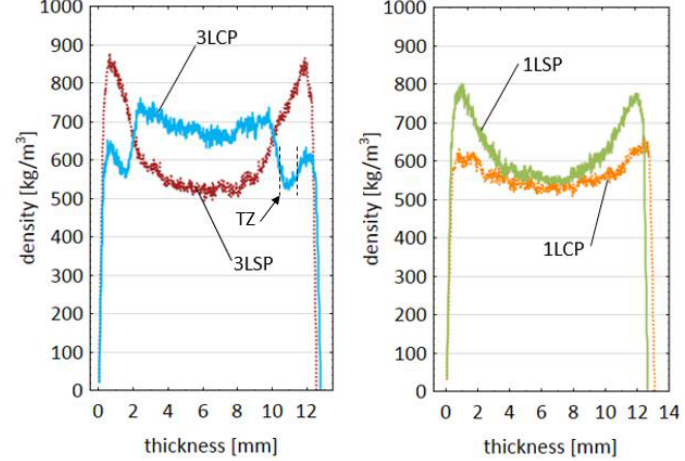
Figure 12. Vertical density profile of the produced particleboards (PBs). 3LCP—three layer-cup-plant PB, 3LSP—three-layer spruce PB, 1LCP—single-layer cup-plant PB, and1LSP—single-layer spruce PB; TZ—transition zone between surface and core layer.